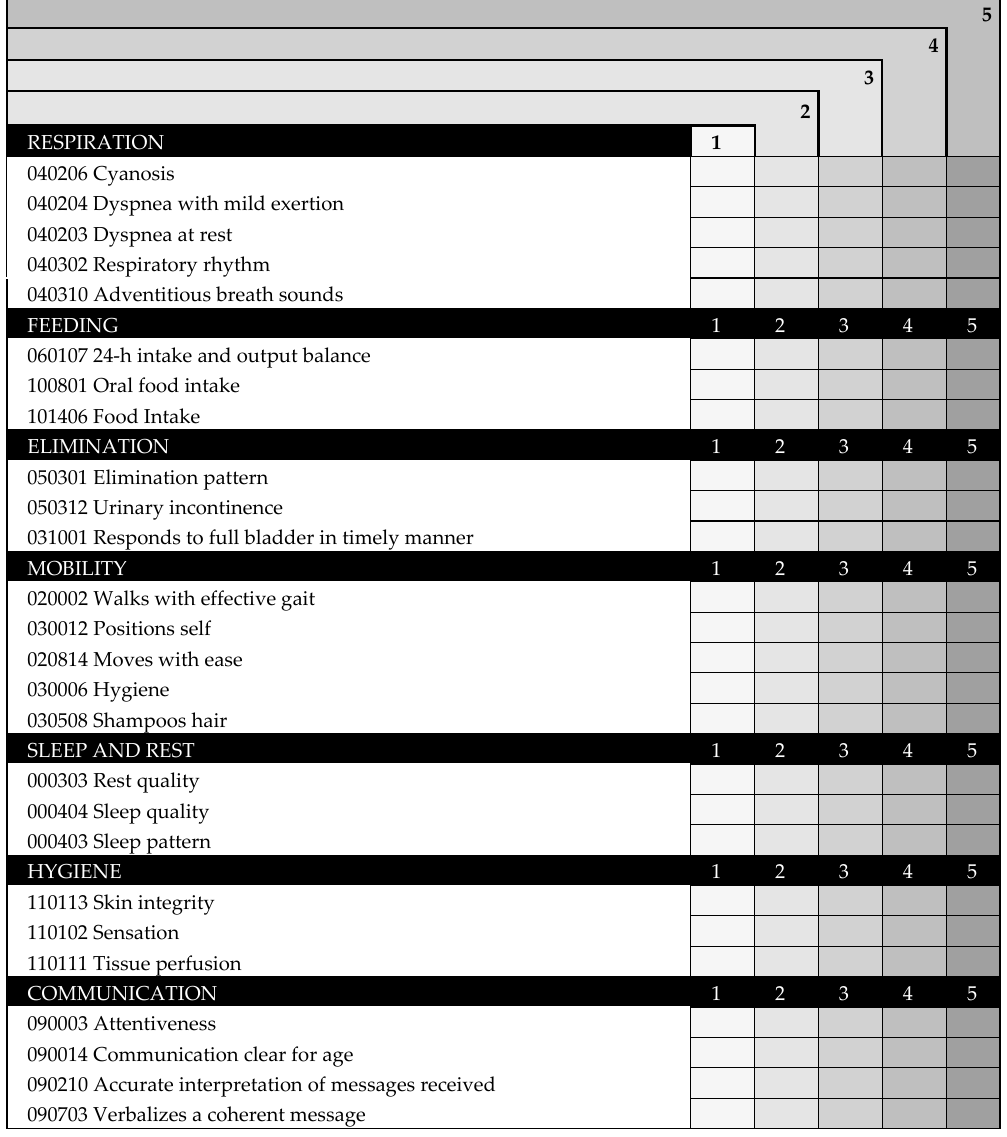
Figure 6. INICIARE-26 English Version.